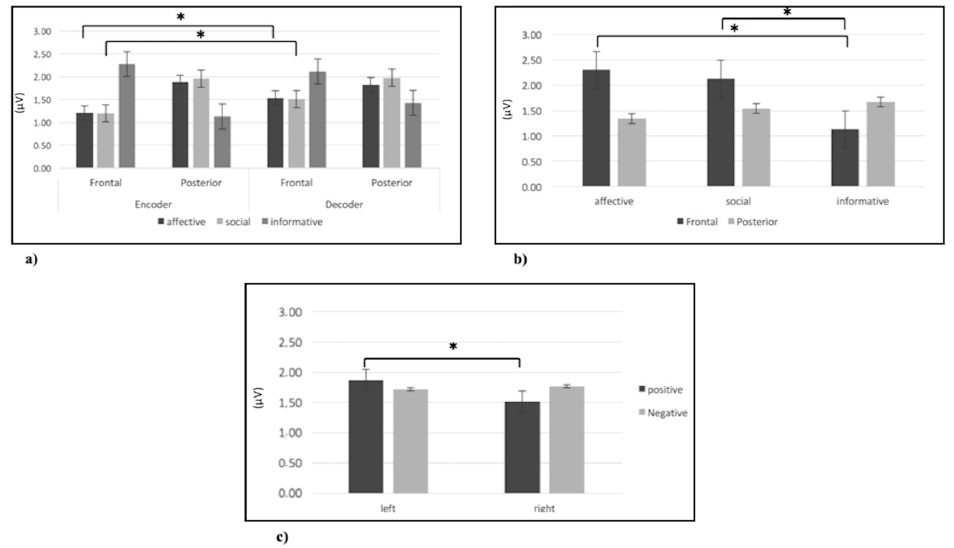
Figure 3. ( a ) Histogram of alpha brain activity for affective, social, and informative gestures in the frontal and posterior (temporo-parietal) areas in the encoder and decoder. The histogram shows an increase of brain activity (decrease of alpha power) in the frontal area for social and affective gestures in the encoder compared to the decoder. Bars represent ∓ 1SE. Stars mark statistically significant ( p < 0.05) pairwise comparisons. ( b ) Histogram of delta brain activity for affective, social, and informative gestures in the frontal and posterior (temporo-parietal) areas. The histogram shows an increase of delta activity in the frontal area for affective and social gestures compared to informative gestures. Bars represent ∓ 1SE. Stars mark statistically significant ( p < 0.05) pairwise comparisons. ( c ) Histogram of theta brain activity for positive and negative gestures in frontal left and right side. The histogram shows an increase of theta activity for positive gestures in the left side. Bars represent ∓ 1SE. Stars mark statistically significant ( p < 0.05) pairwise comparisons.